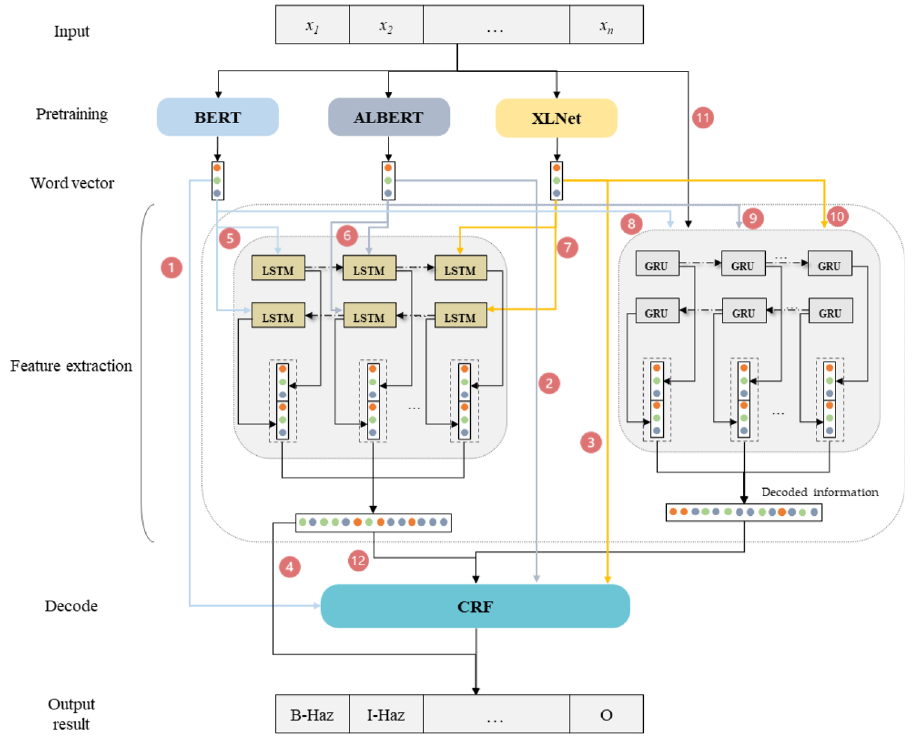
Figure 5. Model selection and framework: (1) BERT-CRF, (2) ALBER-CRF, (3) XLNet-CRF, (4) BERT-BiLSTM, (5) BERT-BiLSTM-CRF, (6) ALBER-BiLSTM-CRF, (7) XLNet-BiLSTM-CRF, (8) BERT-BiGRU-CRF, (9)